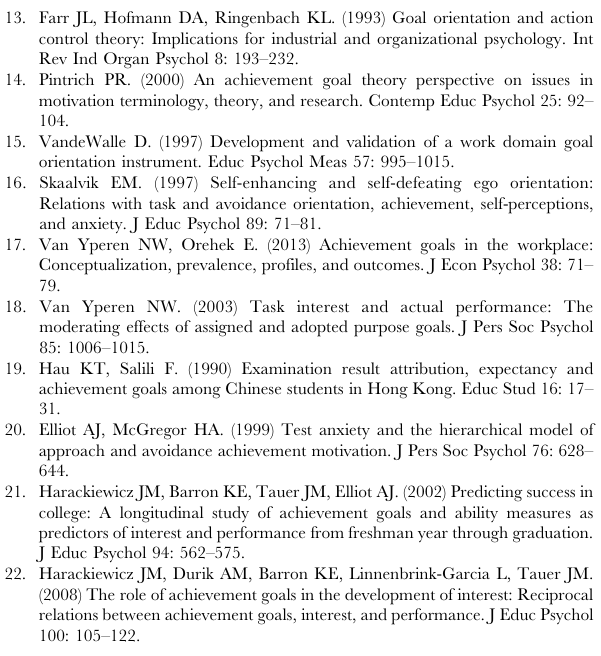
Protocol S1 PRISMA 2009 Flow Diagram